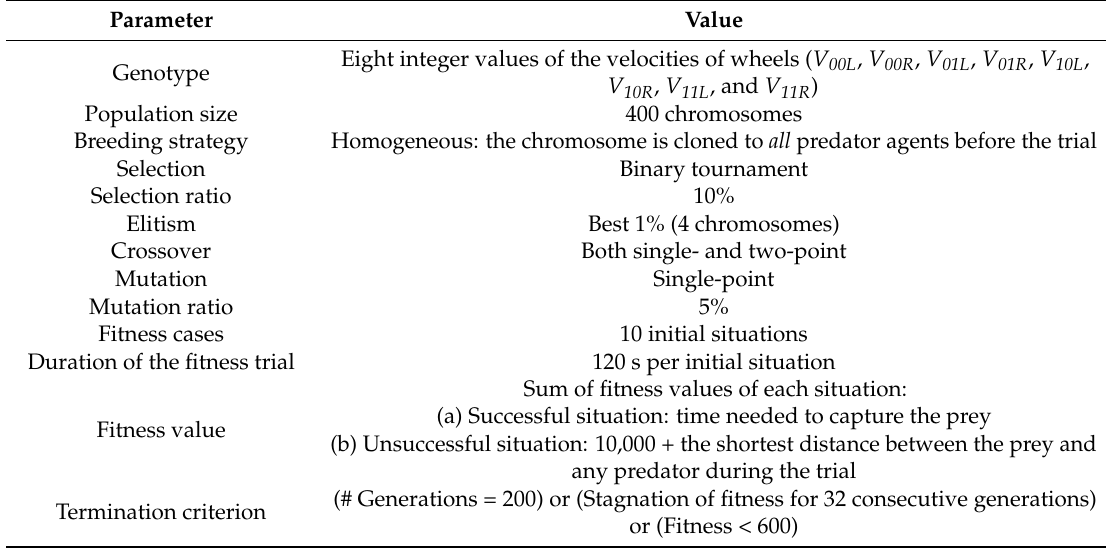
Table 2. Parameters of GA.